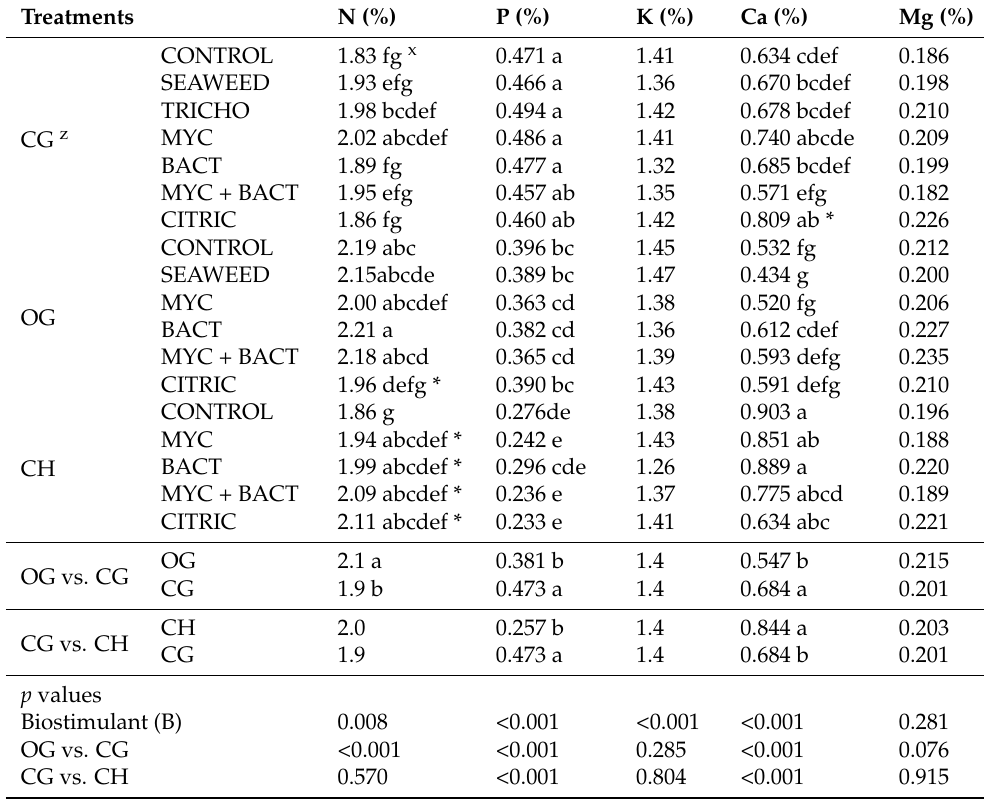
Table 3. Influence of biostimulant treatments on leaf mineral concentrations (% of the leaf dry weight) of strawberry plants grown conventionally and organically under a greenhouse and high tunnel during winter and summer